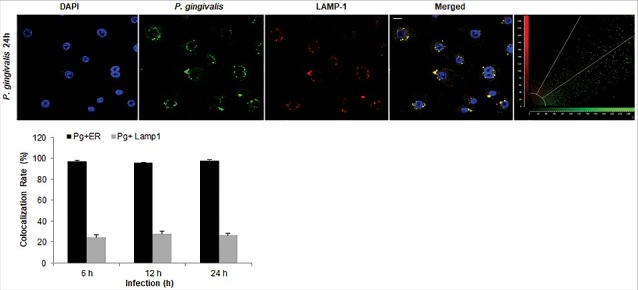
P. gingivalis' localization with LAMP1-positive structures in primary GECs. Quantitative confocal microscopic analysis of P. gingivalis MOI 100 (Alexa 488) colocalization with lysosomes using the lysosomal marker LAMP1 (Alexa 594) at different time points of infection; 6, 12, and 24 hours. Confocal image represents 24 hours of infection and shows only a small subset of bacteria co-localizing with lysosomes, which remains relatively similar throughout the course of infection. Quantification in the bar graph is shown as the mean +/− SD and graphed with the ER tracker colocalization rates from Figure 4 for comparison. 20x micrographs; Bar 10 µm.